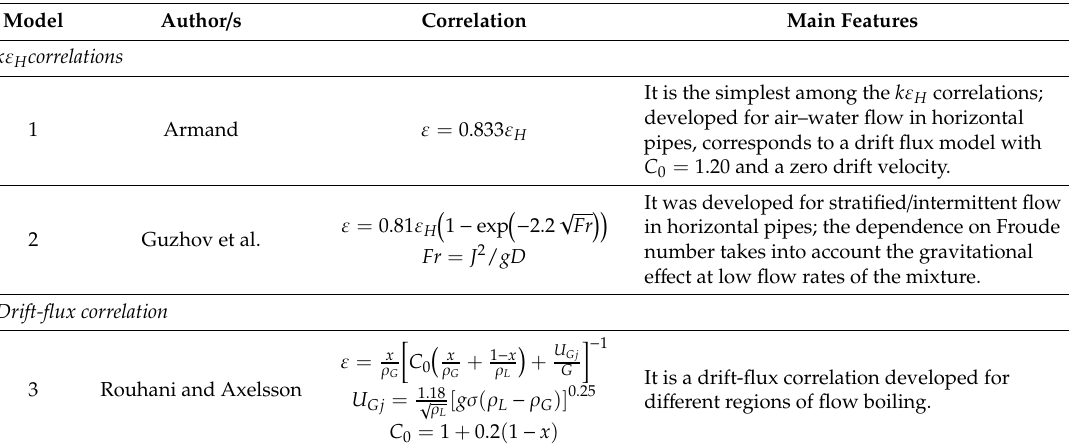
Table 6. Void fraction